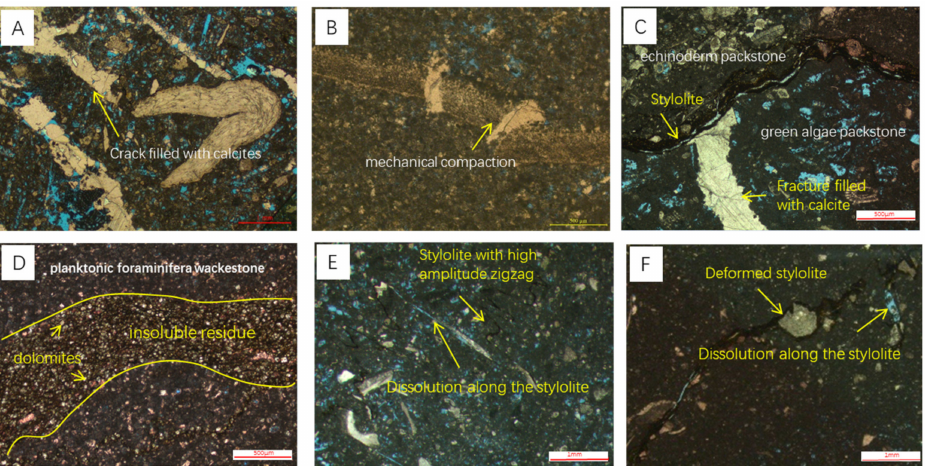
Figure 5. The diagenesis related to the pressure dissolution. ( A ) The irregular cracks in the limestone; ( B ) the compaction of the fossil; ( C ) a weathering crack filled with calcite was cut by a stylolite; ( D ) dolomites in the insoluble residue of dissolution seams; ( E ) a dissolution could be seen at the column of the stylolite; ( F ) the dissolution along the segment of a deformed stylolite in the bioclastic